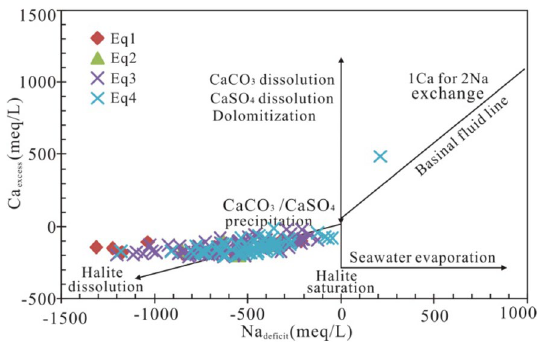
Figure 5. Plot of Na deficit vs. Ca excess for Eocene to Lower Oligocene oilfield brines 34 . The basinal fluid line (BFL) means the theoretical trend for the albitization of primary seawater.